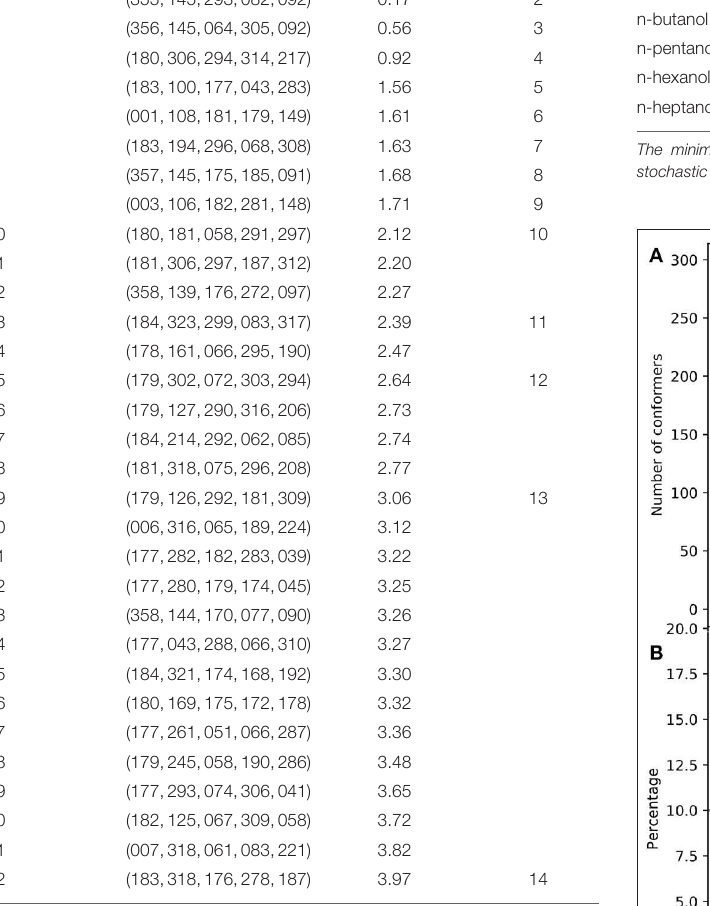
TABLE 2 | L-serine low-energy conformers sorted out according to their relative harmonic Gibbs free energies at 0 K (in kcal/mol) calculated at the B3LYP/6-31++G ** level.